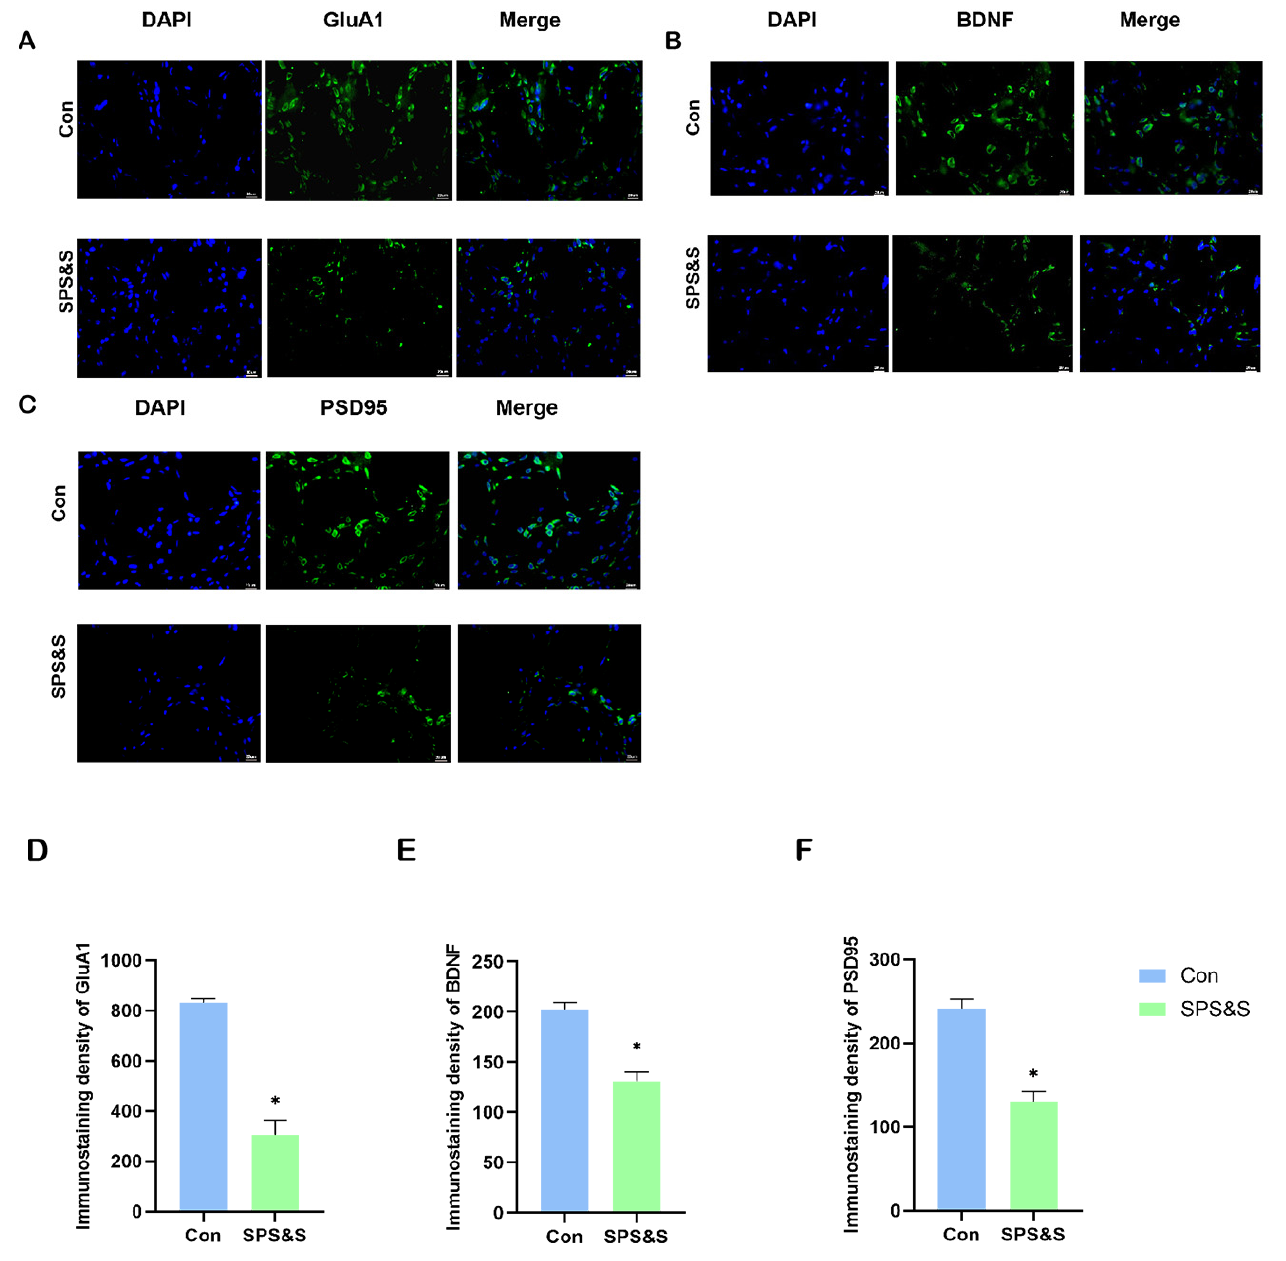
Figure 4. Effects of SPS&S on fluorescence intensities of GluA1, BDNF and PSD-95 protein levels in the mPFC (400 × , bar scale 20 um). The localization and distribution of GluA1 ( A ), BDNF ( B ), and PSD-95 ( C ) in mPFC. The data of the immunoreactivity analysis of GluA1 ( D ), BDNF ( E ), and PSD-95 ( F ) in mPFC. Data are also represented as mean ± SEM. * p < 0.05.